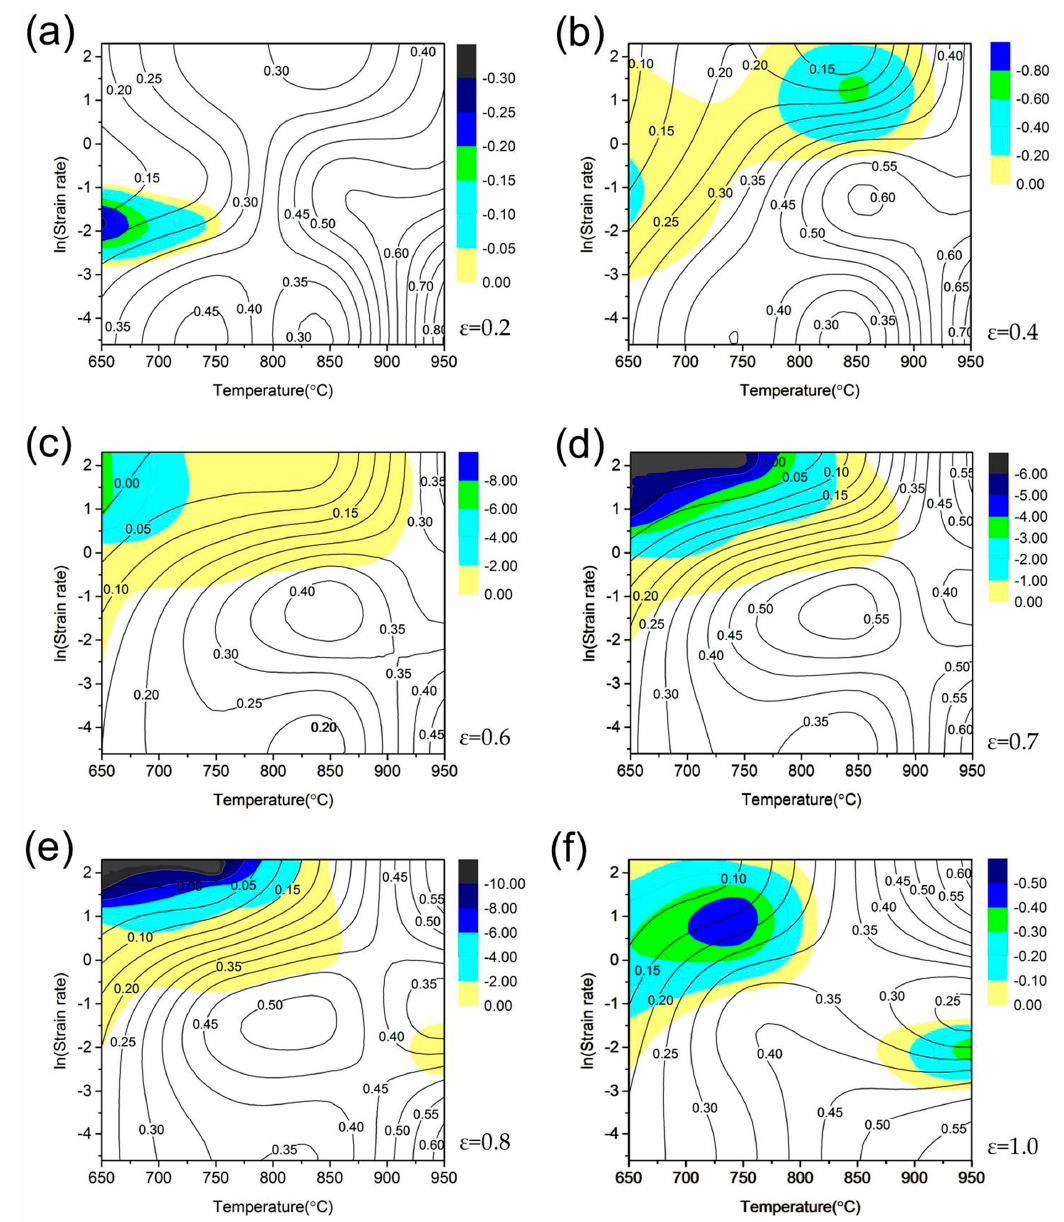
Figure 6. Processing maps of the Fe-6.5wt. %Si alloy at various true strains: ( a ) 0.2; ( b ) 0.4; ( c ) 0.6; ( d ) 0.7; ( e ) 0.8; ( f ) 1.0. The contour lines represent the values of the power dissipation efficiency. The colored areas and bar charts represent the instability levels.